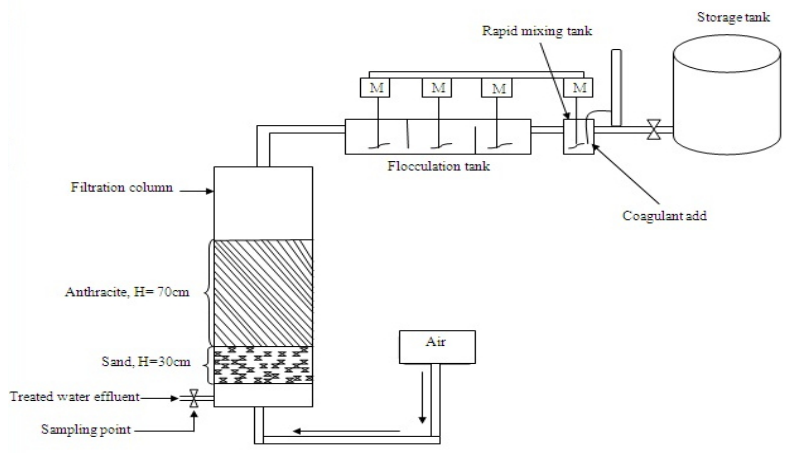
Fig. 1. A schematic of the pilot used in this study